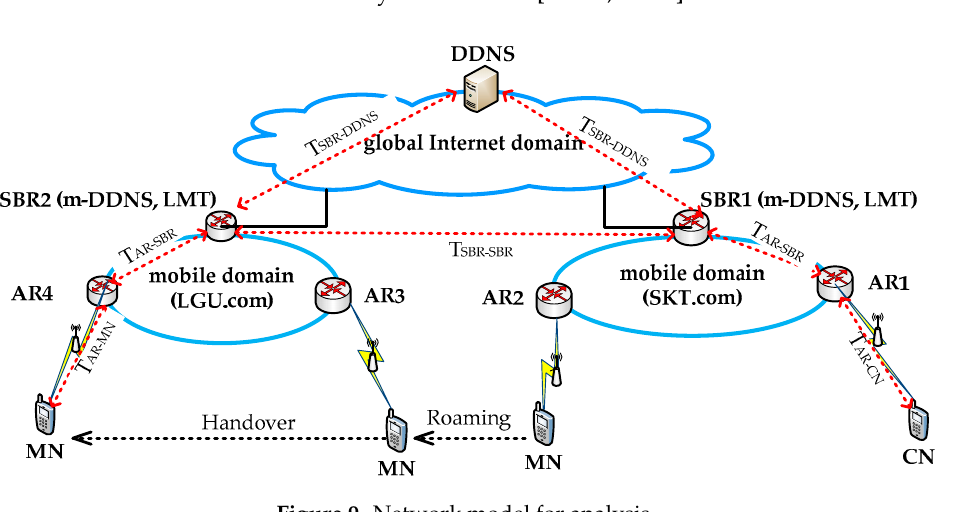
Figure 9. Network model for analysis . Table 4. Parameters used for cost analysis.